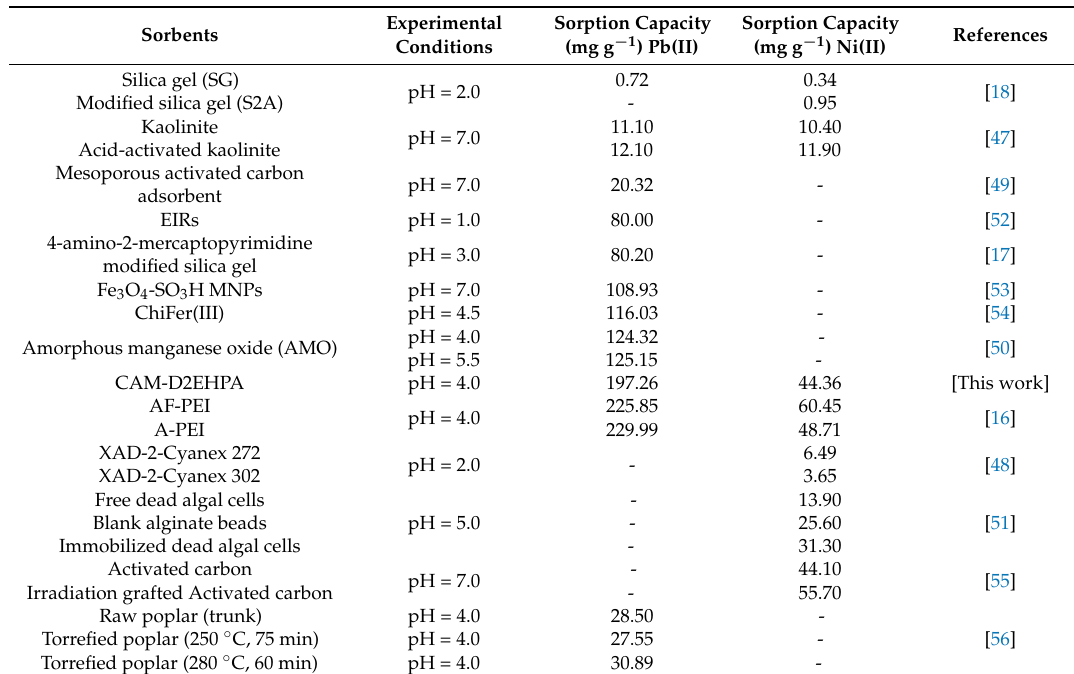
Table 3. Metal removal by different sorbents in the